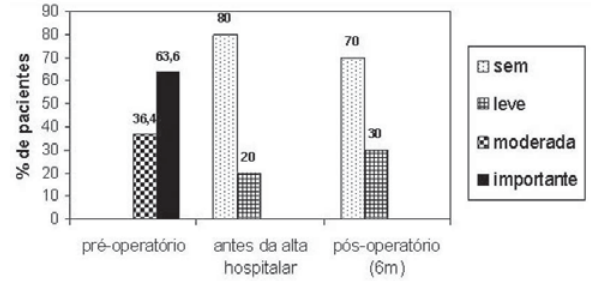
Fig. 2 - Avaliações ecocardiográficas da insuficiência tricúspide